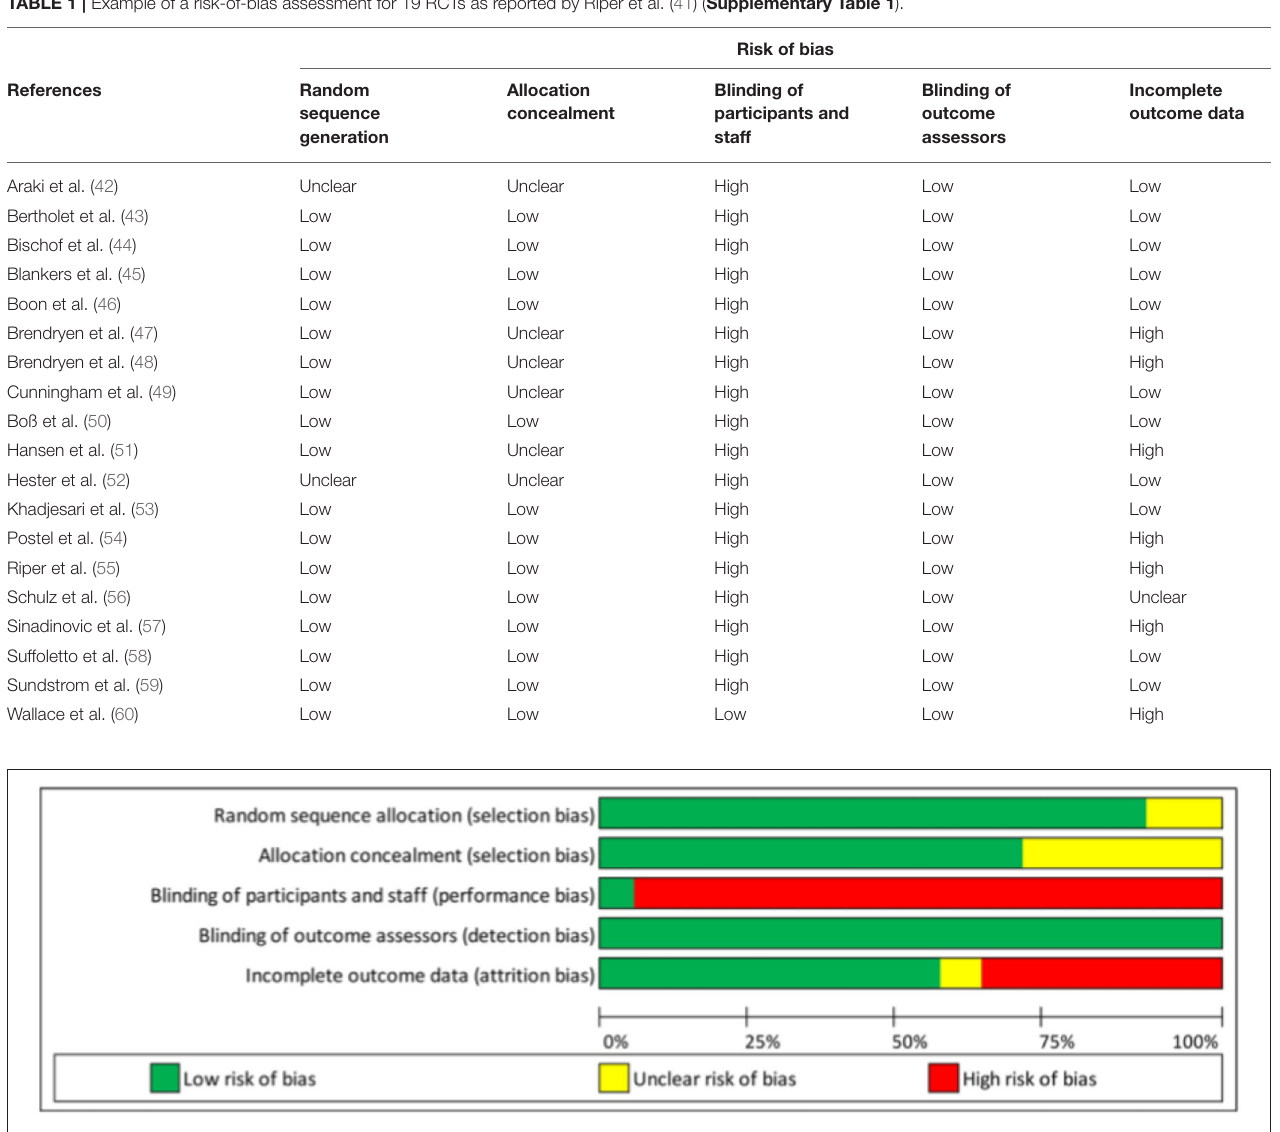
FIGURE 1 | Example of a risk-of-bias representation as reported by Riper et al. (41) ( Figure 2